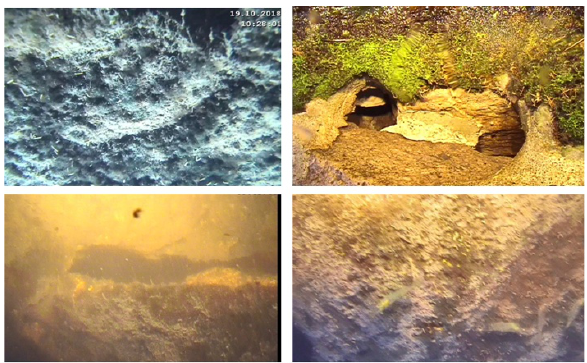
Figure 10. The images of the revetment by endoscope.